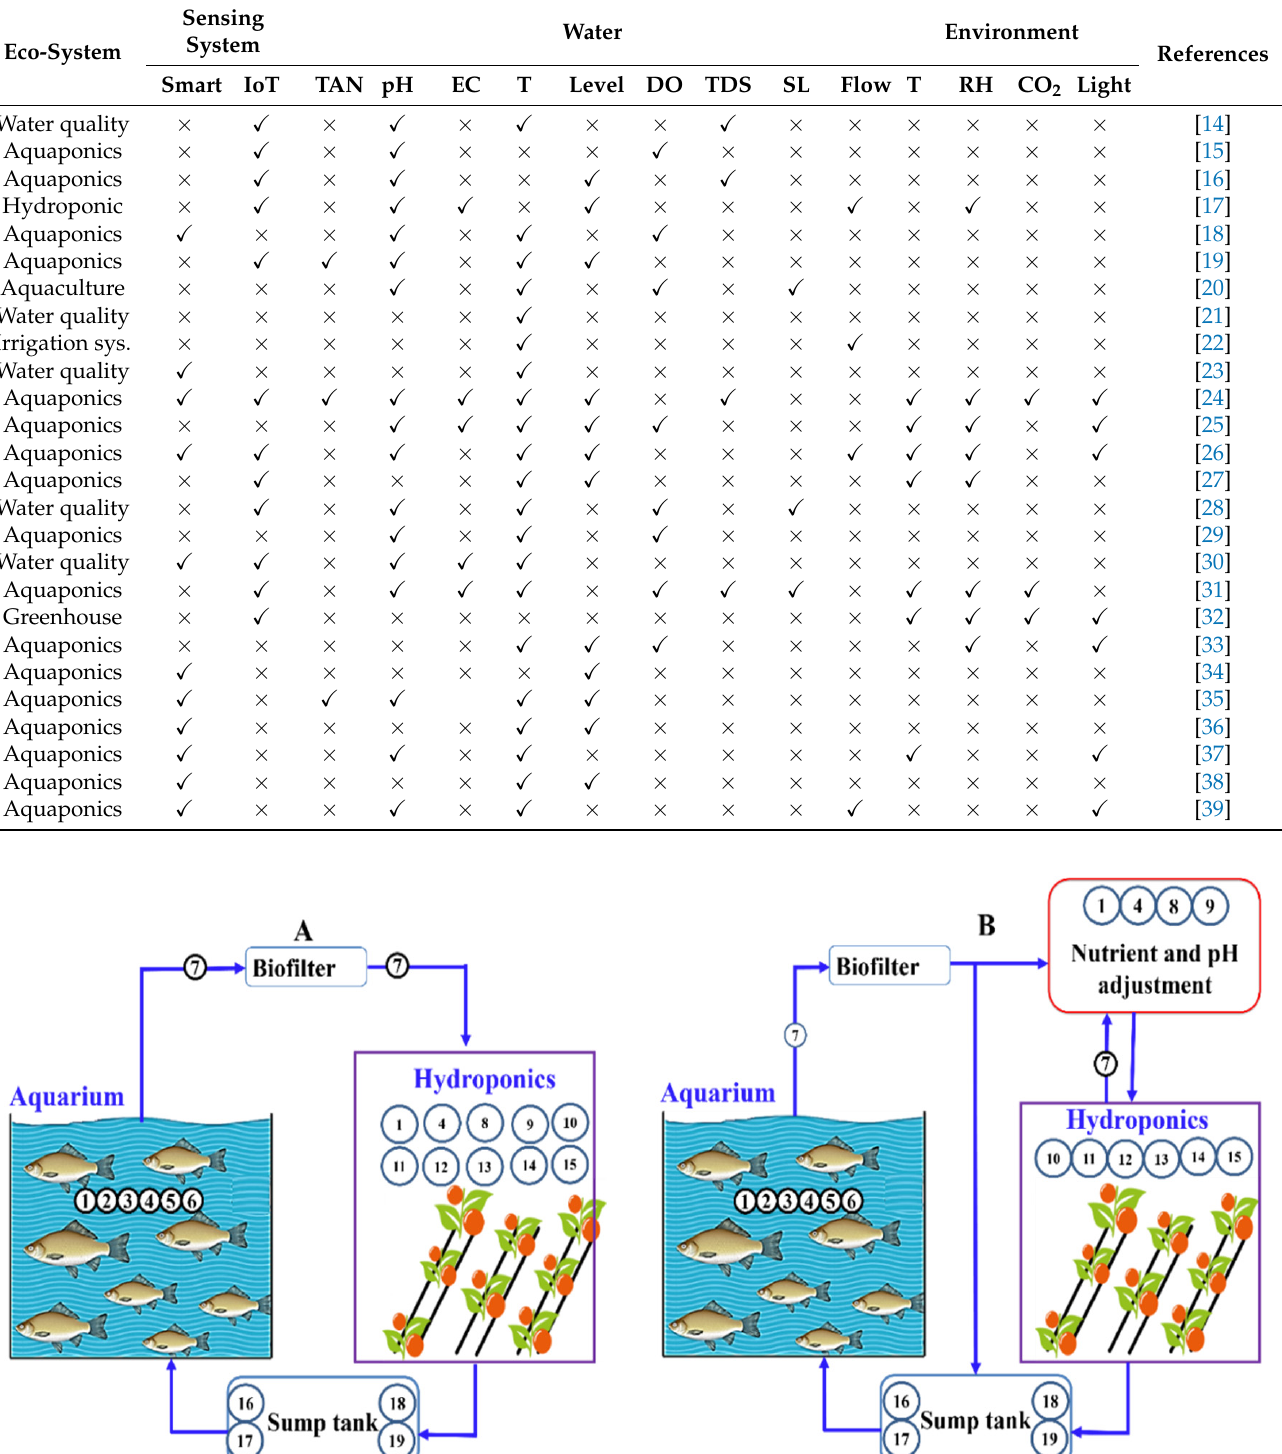
Table 1. List of sensed parameters, smart systems, and IoT systems in selected aquaponics, hydro- ponic, or aquaculture publications.